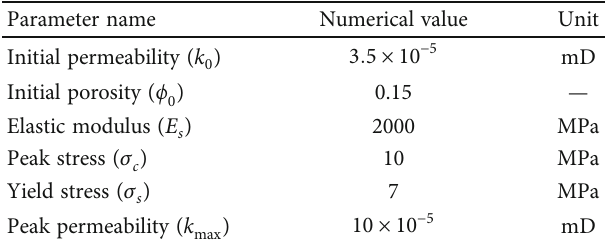
Figure 12: Variation curve of permeability of gas-bearing coal. Table 2: Gas-bearing coal parameters.